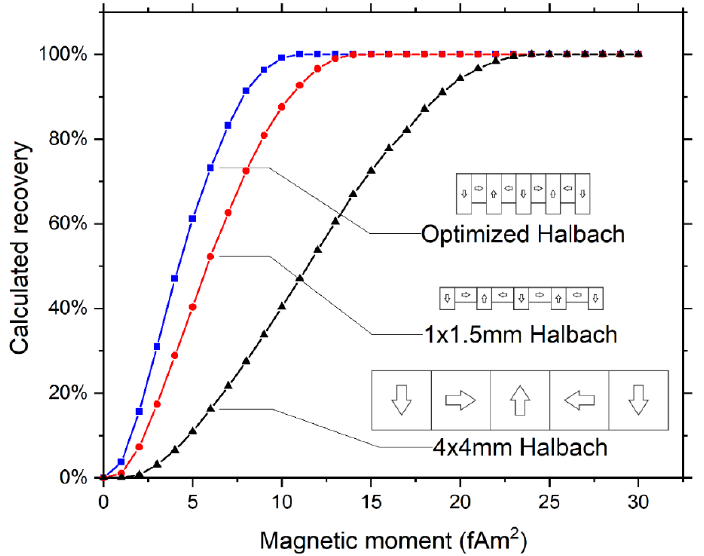
Figure 9. Calculated recoveries using different magnetic arrays showing a decrease in the magnetic moment needed to achieve 100% recovery when magnet elements with a smaller width are used. optimized Halbach configuration has vertically oriented magnets with a width of 1 mm, a height of 2.75 mm, whereas horizontally oriented magnets have a width of 1 mm and height of 2 mm.